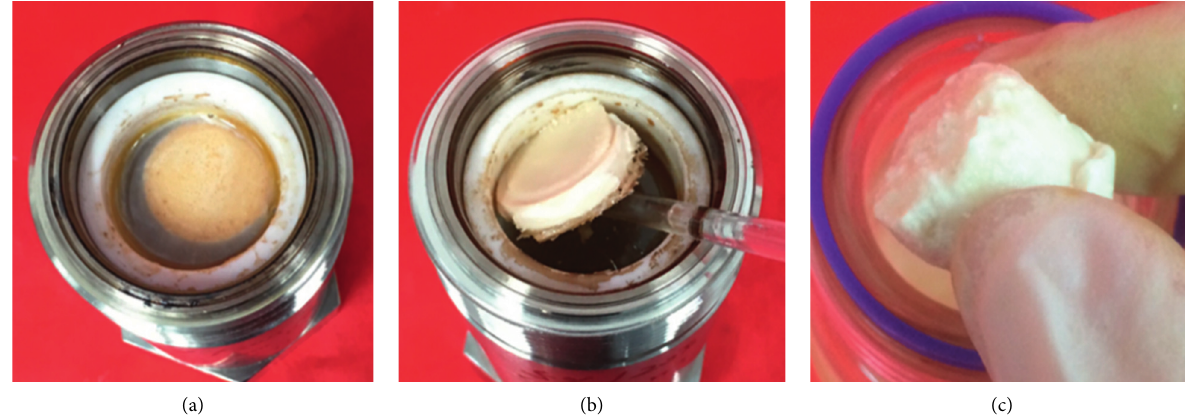
Figure 7: Submillimeter-scale SMG aqueous solution after aging. The upper part is floating with a large cylindrical solid formed by the consolidation of SMG effective components and mineral salts; the lower part is aqueous solution. (a) 1 month, (b) 3 months, (c) 6 months.